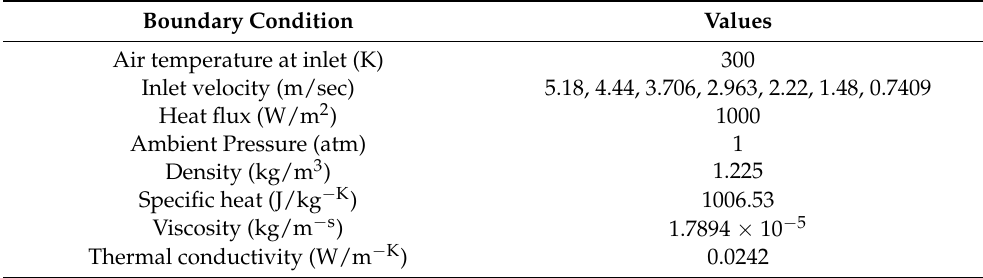
Figure 1. ( a ): Physical model of triangular perforated Y-shaped insert inside a circular tube; ( b ) trian- gular perforated Y-shaped insert for PI = 30%. Table 1. Boundary condition and physical properties of